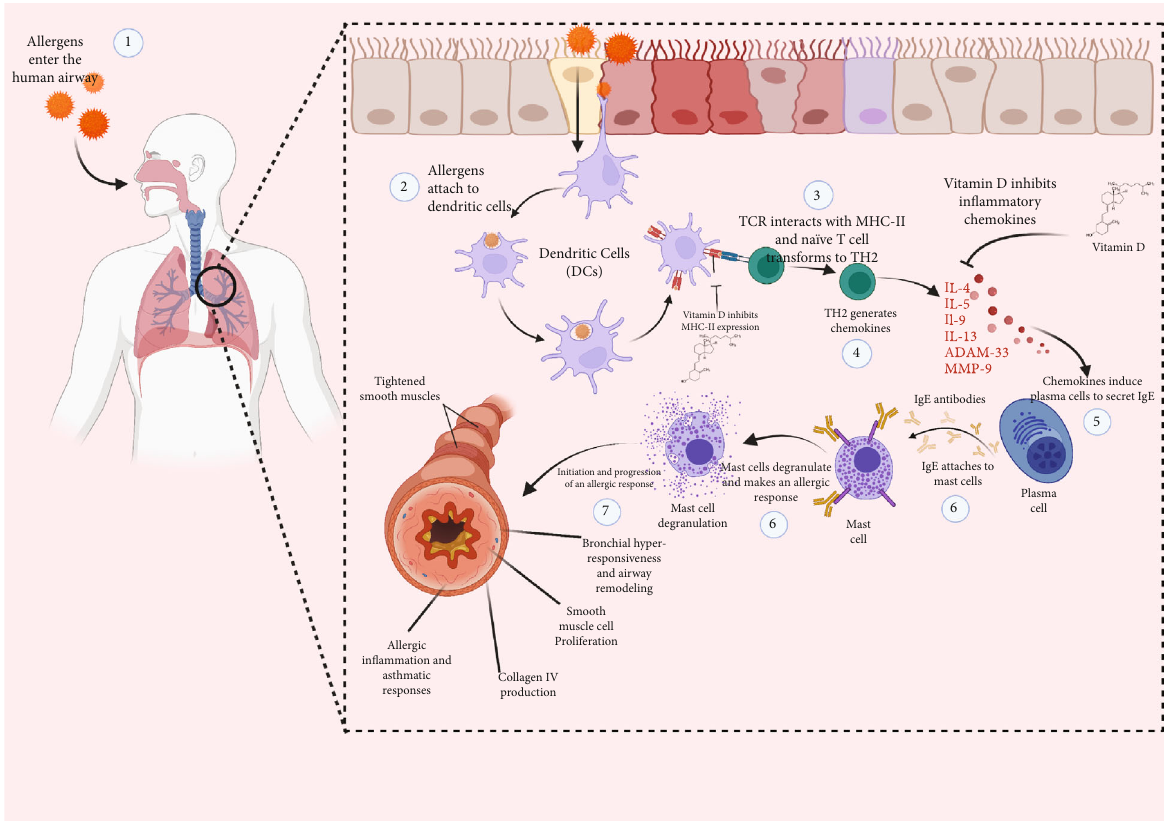
Figure 1: The role of vitamin D in immune mechanisms involved in asthma